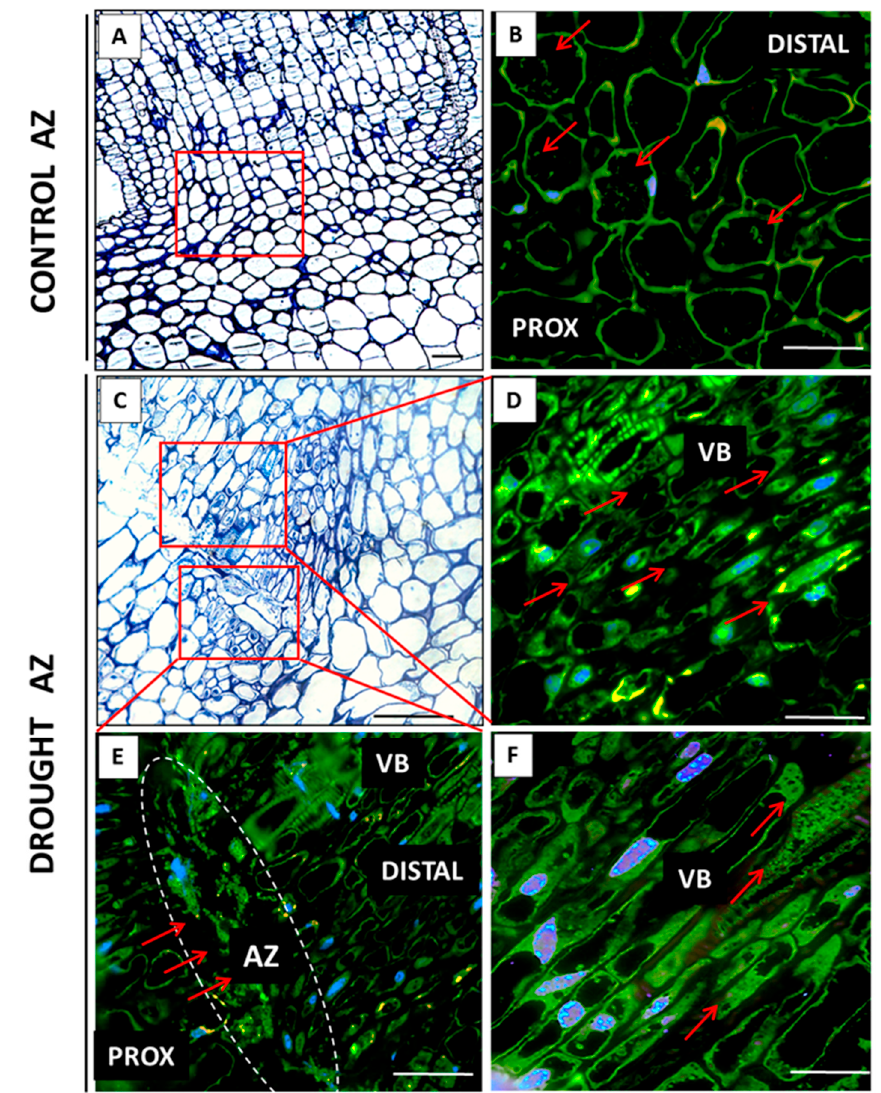
Figure 9. Immunolocalization of ethylene precursor, ACC, in the floral abscission zone (AZ) of yellow lupine grown in drought conditions ( D , E , F ) and in the AZ of control plants ( B ). The AZs were excised on the 48th day of development. Control plants were cultivated under optimal soil conditions (70% WHC), part of plants was subjected to drought conditions for 2 weeks (25% WHC). The AZ region is highlighted by white curves ( E ). The presence of ACC is indicated by red arrows. D and F correspond to vascular bundle areas. Nuclei were stained with DAPI. The studied regions of AZs used for the immunofluorescence studies are marked by red squares ( A , C ). Abbreviations: PROX—stem fragments below the AZ, DIST—flower pedicel fragments above the AZ, VB—vascular bundles. Scale bars: